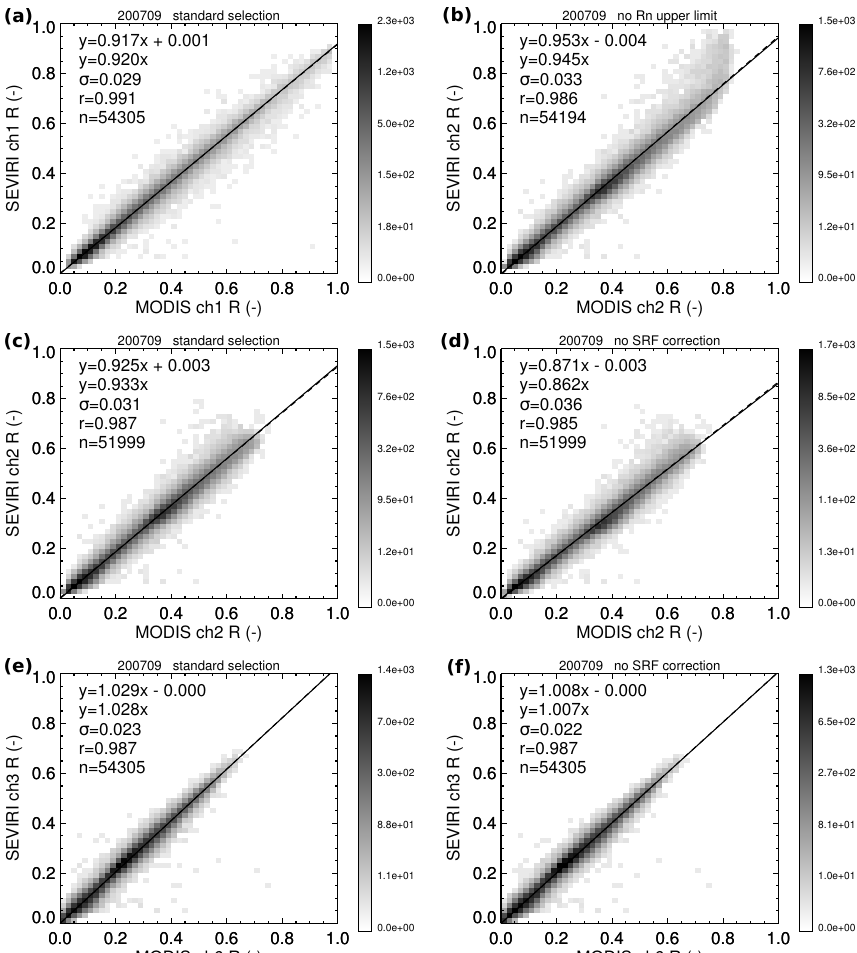
Fig. 4. Monthly (September 2007) fits of SEVIRI-Meteosat-9 against MODIS-Aqua reflectances: (a) channel 1, (b) channel 2 without upper limit to R n , (c) channel 2 with upper limit to R n (this is the standard setting for channel 2; see text), (d) channel 2 without SRF correction, (e) channel 3, (f) channel 3 without SRF correction. For all fits the standard geometric selection criteria have been applied. The free linear fits (dashed) and linear fits through the origin (solid) are indicated in the plots. A cubic colour scale, as indicated by the vertical bars, has been used to make the low densities